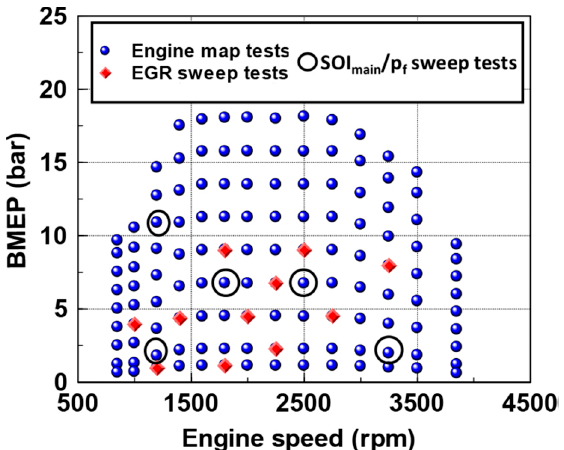
Figure 2. Experimental tests acquired at the test bench.